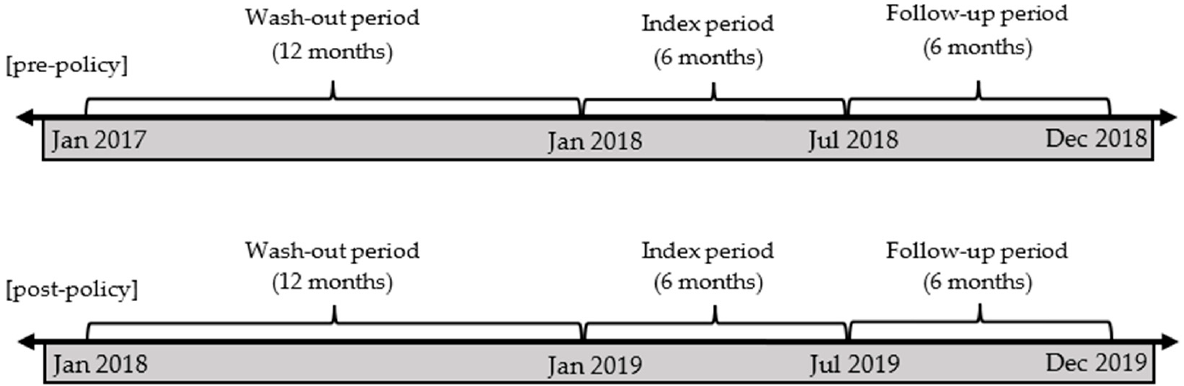
Figure 1. Study design.